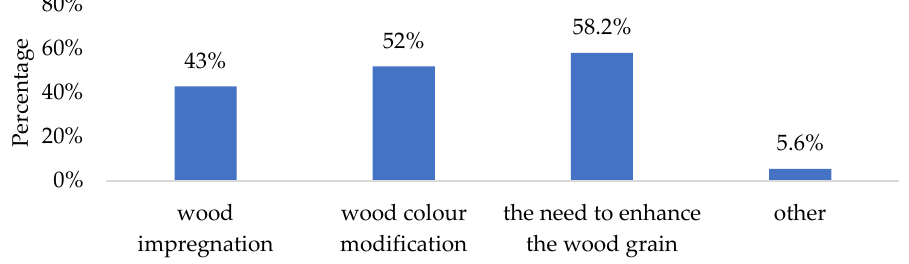
Figure 2. Main reasons for changing the colour tone of the wood. Slovak MSM WFEs offer mainly products in brown colour tones (84.2%). The second most frequently offered colour of the products is white (42.5%) and the third is black colour (31.2%). Only 26.1% of respondents are promoting grey tones of wood products. Only 18.4% of Slovak MSM WFEs have yellow wood products in their portfolio. The “other” option was marked by 5.4% of respondents. As [6,7,37,38] point out, current fashion trends are trying to increase in people the sense of connection with nature. This is also one of the reasons why brown or body colour have been ranked among the most fashionable tones since 2020. Brown colour is the closest to the colour of nature and thus also to wood [2]. Other achieved results correspond to this fact, as up to 73.3% of respondents work mainly with matt wood, mainly the furniture enterprises. Gloss wood is preferred by only 26.7% of MSM WFEs. As [4,30] emphasizes, it is necessary to distinguish the natural gloss of wood, which is influenced by the composition of wood mesh, cut or quality of machining and gloss achieved by the use of chemical coating materials. Hydrothermal treatment of wood by steaming is a modern way to change its colour tone. Since the application of this technique to change the colour of wood requires remarkable investments in the production process, the subject of examination was to identify whether the Slovak MSM WFEs had already heard about the hydrothermal treatment of wood by steaming and whether they have applied this process. Through this question, the authors were able to verify the validity of the assumption made in the hypothesis H2—it is assumed that most Slovak MSM WFEs know the process of hydrothermal treatment of wood by steaming, but do not use it because of the financial burden of introducing this process into production. As shown in Table 3, the p -value is lower than the level of significance, i.e., the hypothesis has been confirmed. The achieved results are also supported by [33,36,39–44], who stress that it is essential to comply with production parameters in the process of hydrothermal treatment of wood. It is necessary to adjust correctly and maintain both temperature and pressure or vacuum in hydrothermal treatment facilities. Table 3. Binomial test results for hypothesis H2. Binomial Test Category